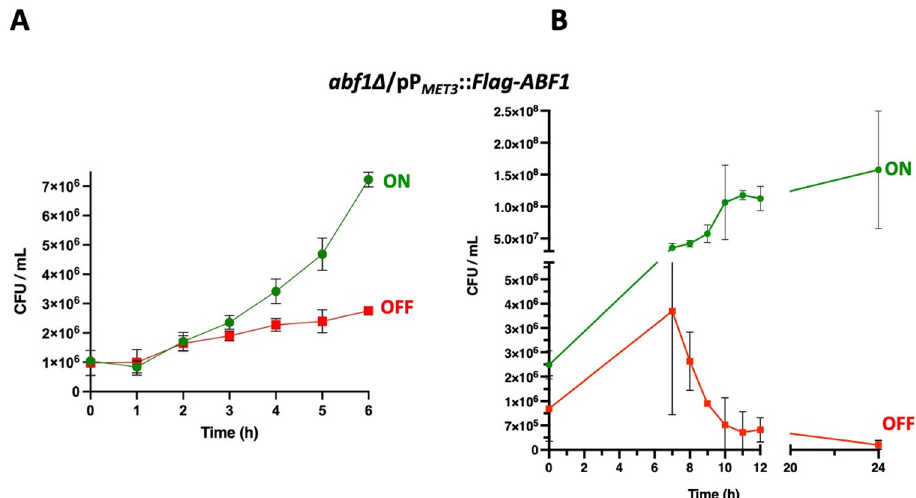
Figure 3 . Repression of ABF1 results in loss of cell viability. ( A ) Stationary phase cultures of strain abf1 ∆ /pP MET3 ::Flag- ABF1 were adjusted to an OD 600 of 0.1 and diluted in either YNB minimal media (ON in green) or in YNB + 0.2 mM each cys and met (OFF in red) and incubated at 30 °C with shaking. Samples were taken to determine viable counts (expressed as colony-forming units or CFU) every hour for the first six hours. ( B ) In an independent set of experiments, samples were taken to determine CFUs as in section A, every hour starting at 7 h after inoculation into each medium until 12 h and another sample at 24 h (graph on the right). All the results shown represent the mean of three independent experiments, and bars correspond to the SD. Analysis of the data was done with Two-Way ANOVA and Tukey’s test using GraphPad, PRISM (See Section 2.9).